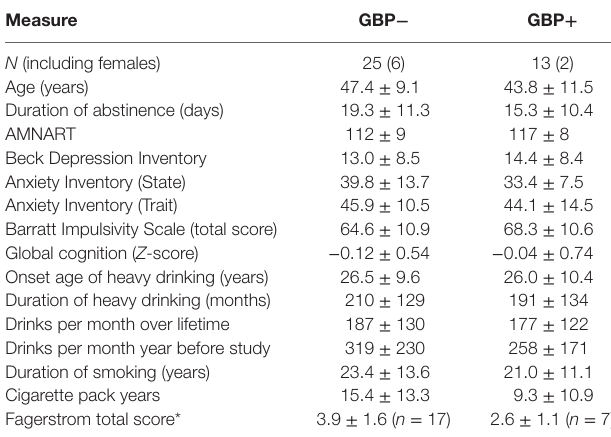
TaBle 1 | Demographic, clinical, and neuropsychological group